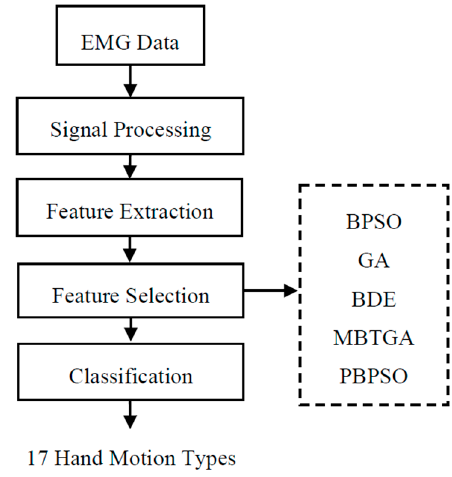
Figure 1. Flow chart of the proposed electromyography (EMG) pattern recognition system.